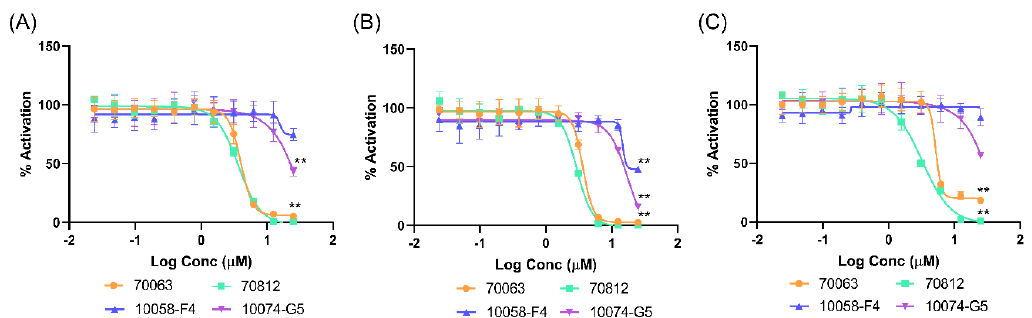
Figure 5. 70812’s IC 50 in N-Myc driven cell lines. The N-Myc inhibitory activity of compound 70812 in comparison to 70063, 10058-F4, and 10074-G5 in 22Rv1 ( A ) , LNCaP ( B ), and HO15.19 ( C ), administered through serial concentration. All experiments were performed with N = 4 replicates. p -values were obtained using an unpaired t test against the vehicle control. Di ff erences were considered significant p < 0.005 (**).